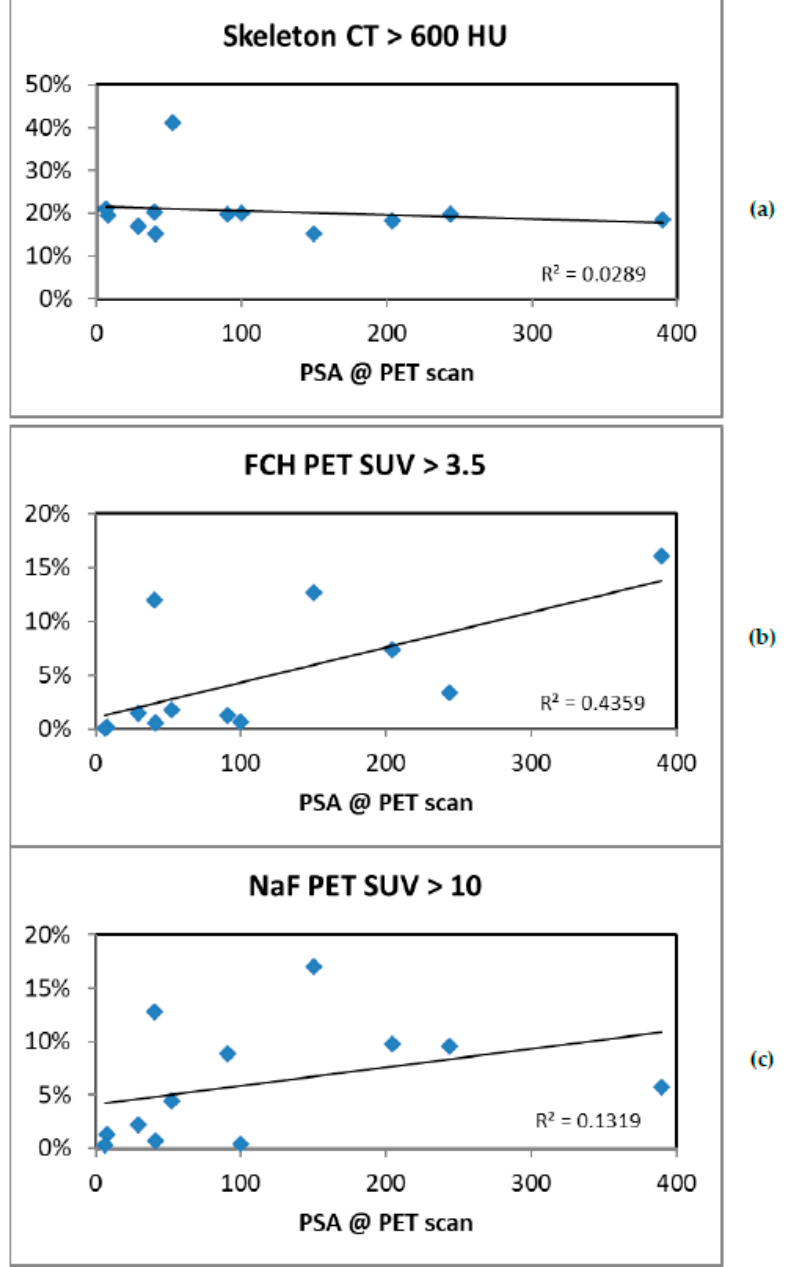
Figure 3. Volumes of sclerosis (HU > 600) ( a ), total choline kinase activity (SUV > 3.5 on FCH PET) ( b ) and total bone demineralization activity (SUV > 10 on NaF PET) vs. serum PSA ( c ). PSA correlated with total choline kinase activity ( p < 0.02). PSA did not correlate with the amount of sclerosis seen on CT ( p > 0.5) nor with the bone demineralization activity ( p > 0.2). S-PSA is presented as ng/mL and volumes as percentages of total skeletal volume.